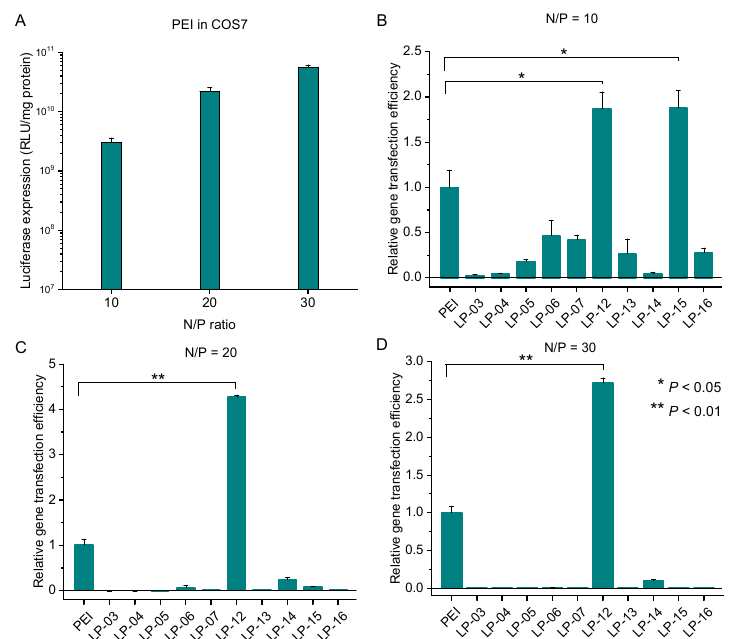
Figure 10. In vitro gene transfection efficiency of the complexes of PEI/pDNA in COS7 cells in the presence of serum at different N/P ratios ( A ). Relative gene transfection efficiency of the complexes of LP/pDNA in COS7 cell line in the presence of serum at N/P of 10 ( B ), 20 ( C ) and 30 ( D ). Data represent mean ± standard deviation (* p < 0.05, ** p < 0.01, n = 2). In the cell line of MDA-MB-231 (Figure 11), at the lower N/P ratios of 10 and 20, LP- 12 was the best copolymer in gene transfection among all the copolymers. Its gene trans- fection efficiency was comparable to PEI at N/P of 10. The value was further increased to be nearly five times higher than PEI at N/P of 20. When N/P ratio was further increased to 30, its gene transfection efficiency decreased to ca. 1.7 times of PEI. By comparison, at the N/P ratio of 30, LP-14 showed the highest gene transfection efficiency, which was ca. 11 times higher than PEI. From the evaluation of these lignin-PDMAEMA copolymers in the three different cell lines, it can be found that both LP-12 and 14 are most promising nonviral gene transfection vectors.